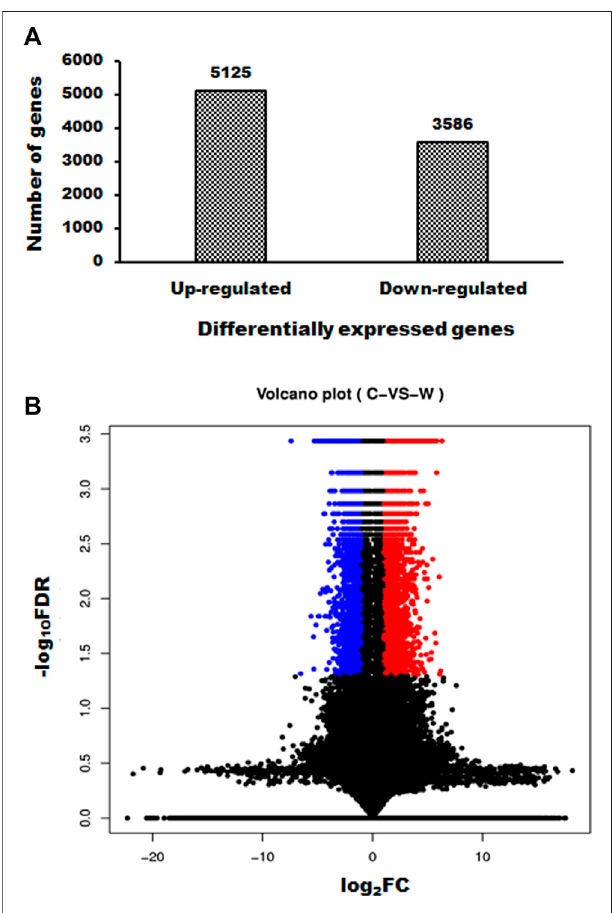
FIGURE 2 | Summary of gene numbers that are signi fi cantly up or downregulatedbetweenWGMextracts-treatedandcontrolcells. (A) Atotalof 8711 genes (5125 upregulated and 3586 downregulated) was found to be differentially expressed between WGM extracts-treated and control samples. (B) Volcano Plot software was used to display the differentially expressed genes between WGM extracts-treated and control samples ( p < 0.05, fold change > 2). On the x-axis , the values of log 2 of the fold change between the WGM extracts-treated and control samples are plotted. The y-axis shows the − log 10 of the calculated probability ( p -value). All results are representative of three independent experiments. (red, upregulated genes; blue, downregulated